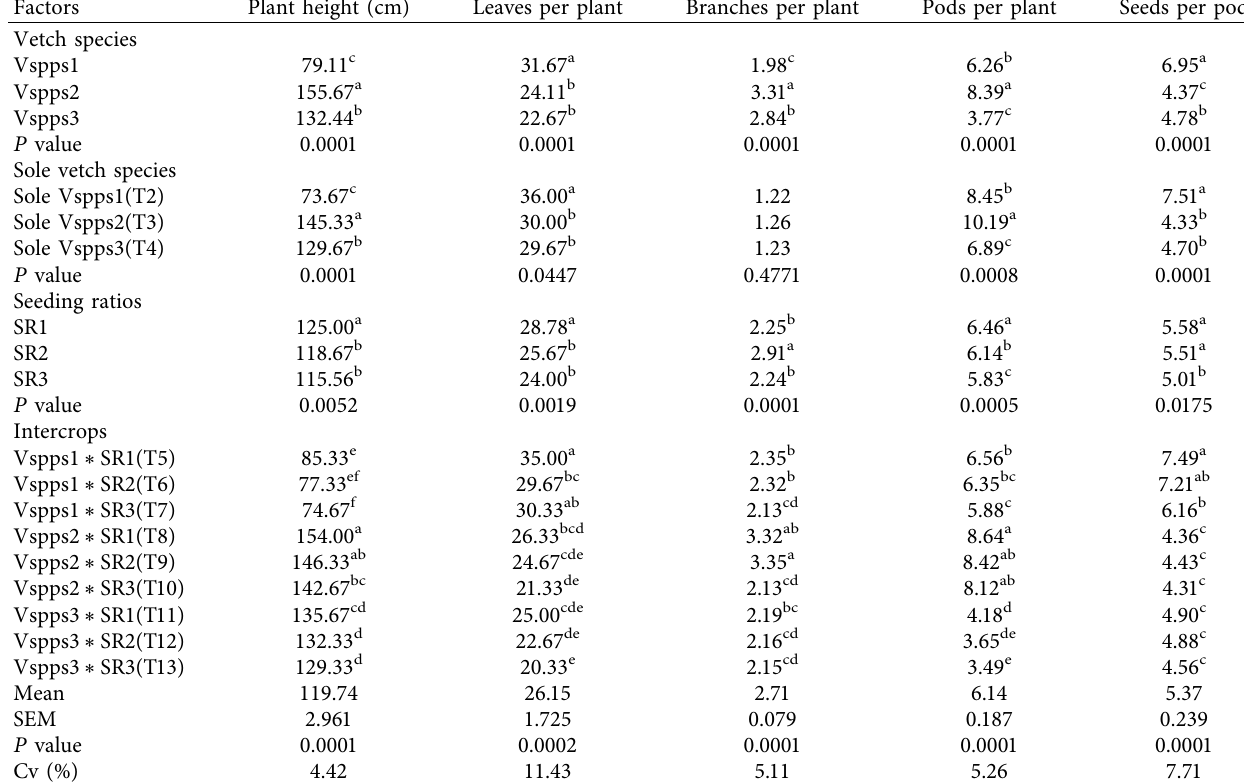
Table 3: Effect of vetch species and seeding ratio on plant height (cm), leaves per plant, branches per plant, pods per plant, and seeds per pod of